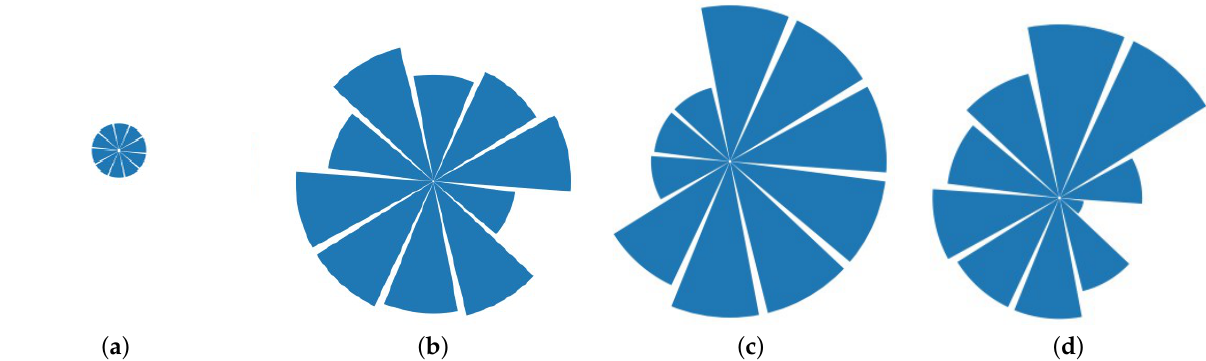
Figure 5. Representative temporal bar graph patterns in a multi-load combination (MW + WM). ( a ) Both appliances are off, ( b ) WM is on, ( c ) MW is on, and ( d ) Both appliances are on.